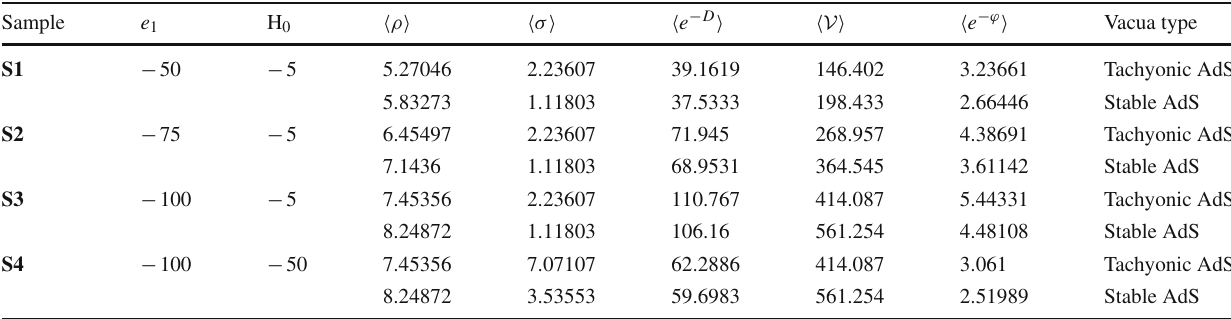
+ (cid:10) ξ (cid:11) H 1 = 0 0 1